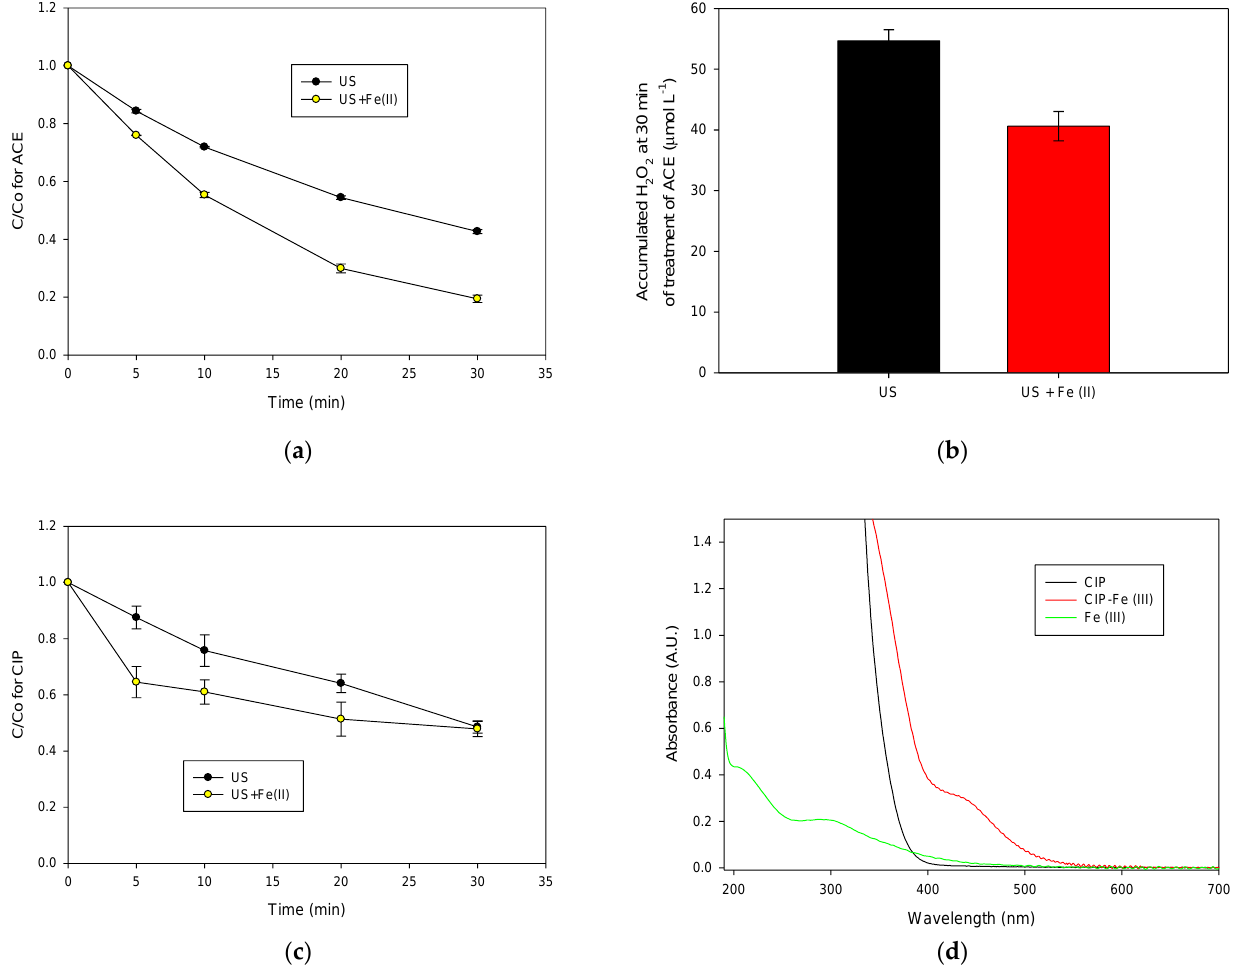
Figure 4. Treatment of ACE and CIP by the homogeneous sono-Fenton process ( a ) Degradation of ACE; ( b ) H 2 O 2 accumulation during the treatment of ACE; ( c ) Degradation of CIP, ( d ) Experimental evidence based on the UV-Vis spectrum for the formation of the CIP-Fe 3+ complex. Experimental con- ditions: f: 375 kHz, P: 34.4 W, [ACE] initial : [CIP] initial : 30.6 µ mol L − 1 , [Fe 2+ ]: 1.0 mg L − 1 , pH initial : 5.6, and V: 250